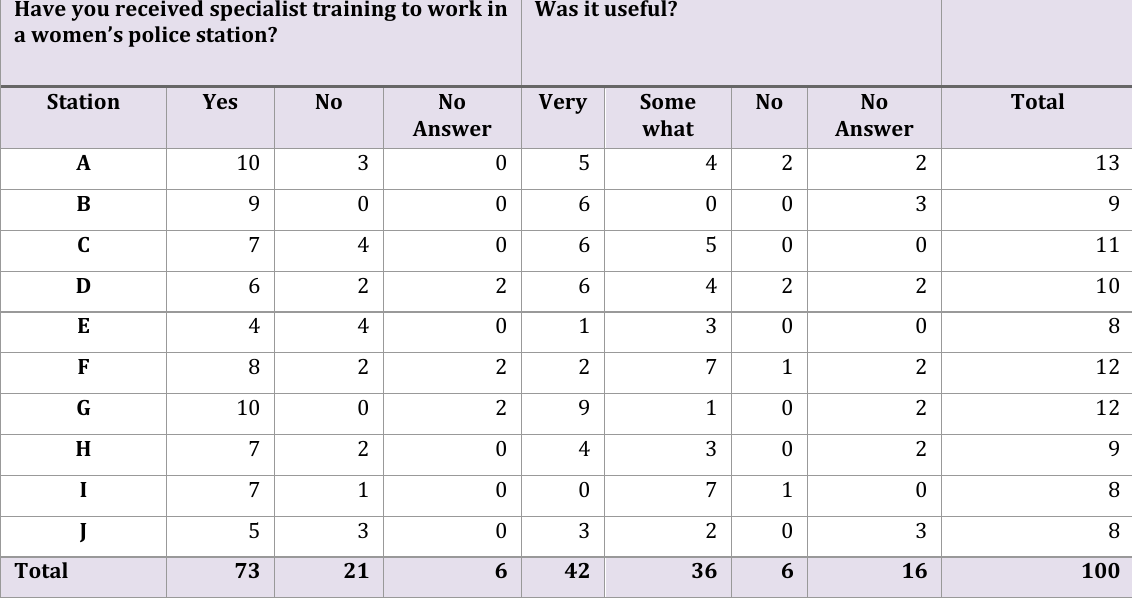
Have you received specialist training to work